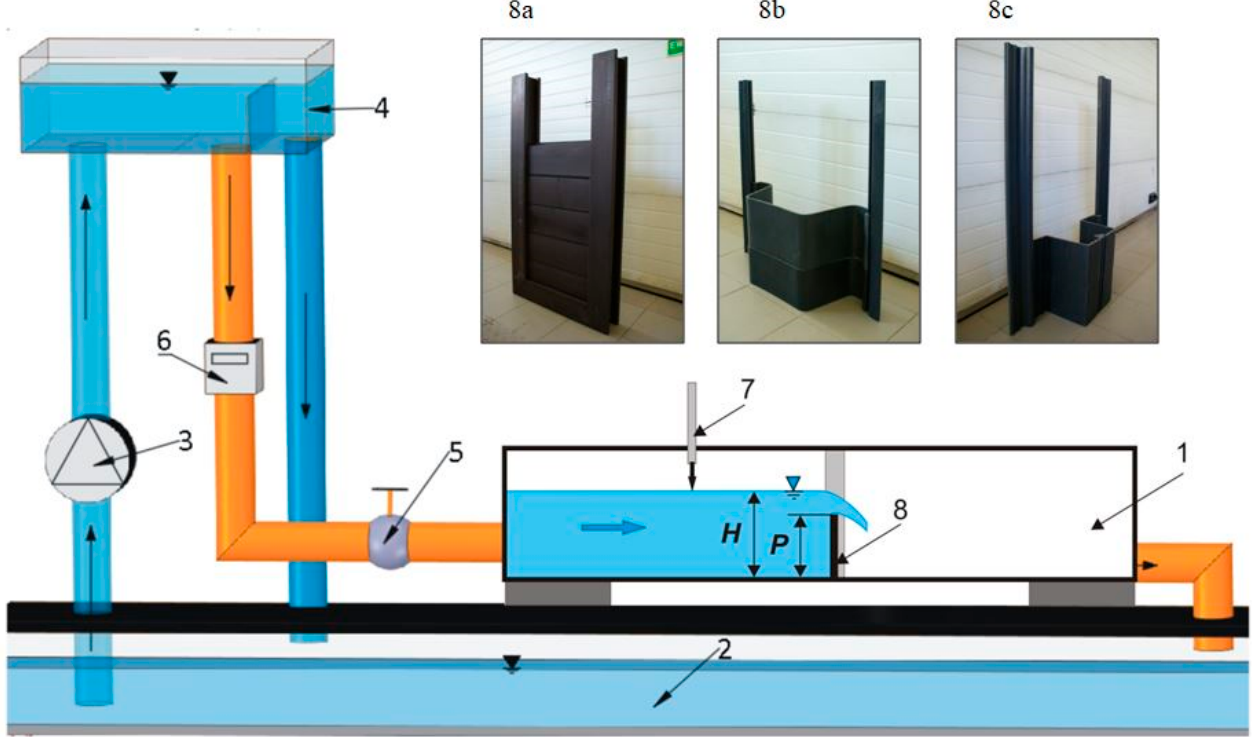
Figure 2. Scheme of the entire experimental site: 1—flume; 2—bottom tank; 3—pump; 4—upper stability tank; 5—regulating valve; 6—electromagnetic flow meter; 7—precise water gauge; 8—regulators of water damming in the ditches; 8a—rectilinear regulator; 8b—labyrinth regulator; 8c—compound regulator; H (cm)—top water depth; P (cm)—height of the regulator overflow (photo by Z. Popek).